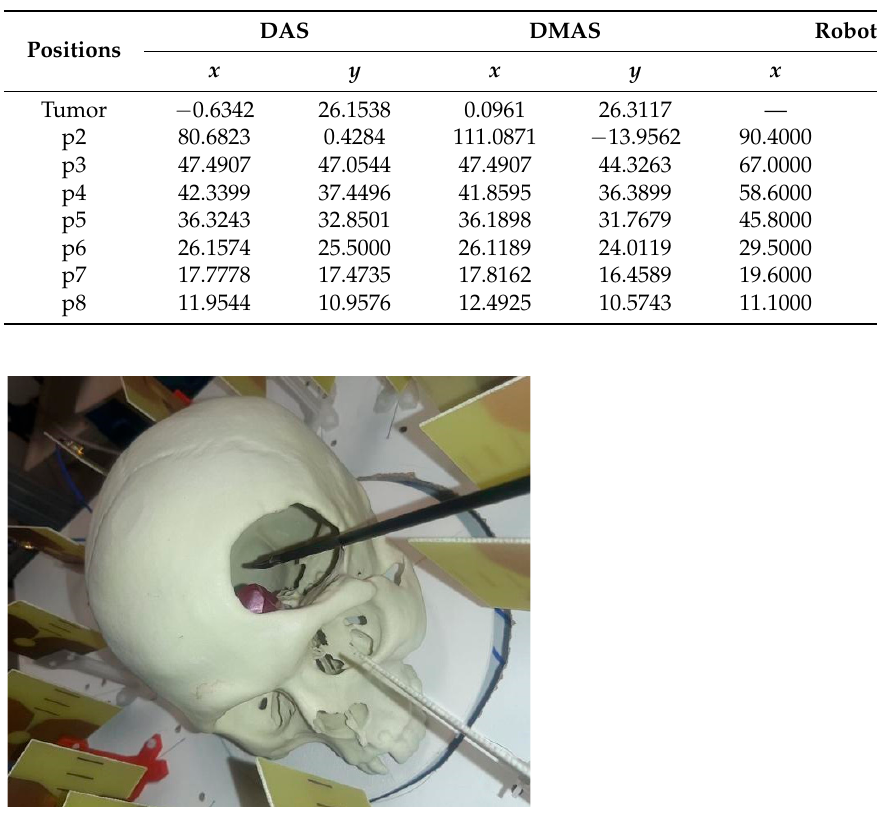
Figure 17. Tool inside the cranium at position p7.